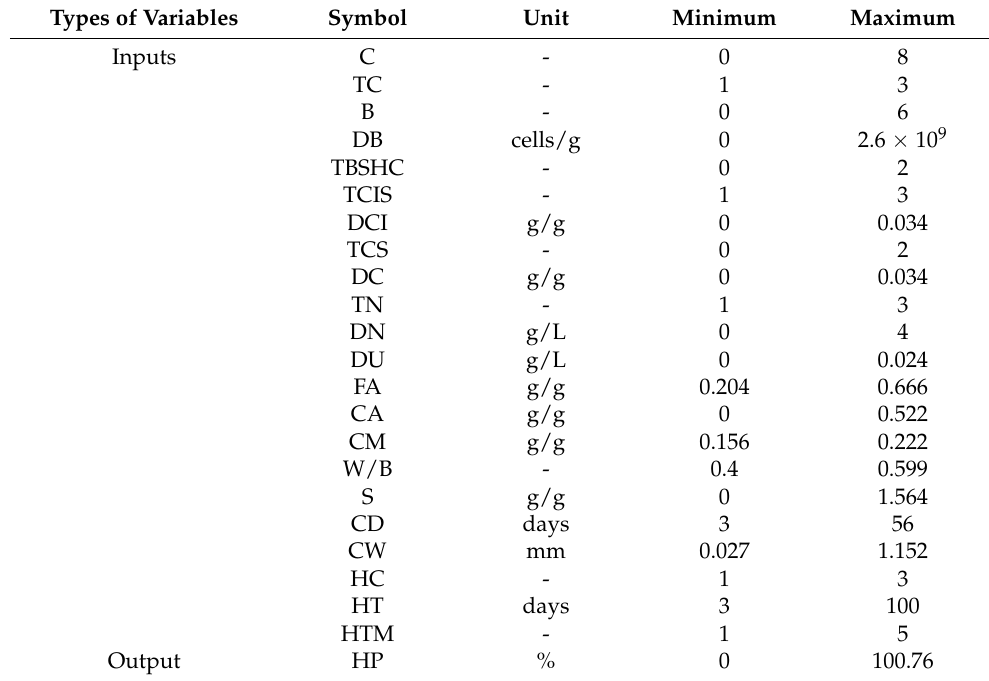
Table 1. The ranges of the variables (inputs) and the output. Types of